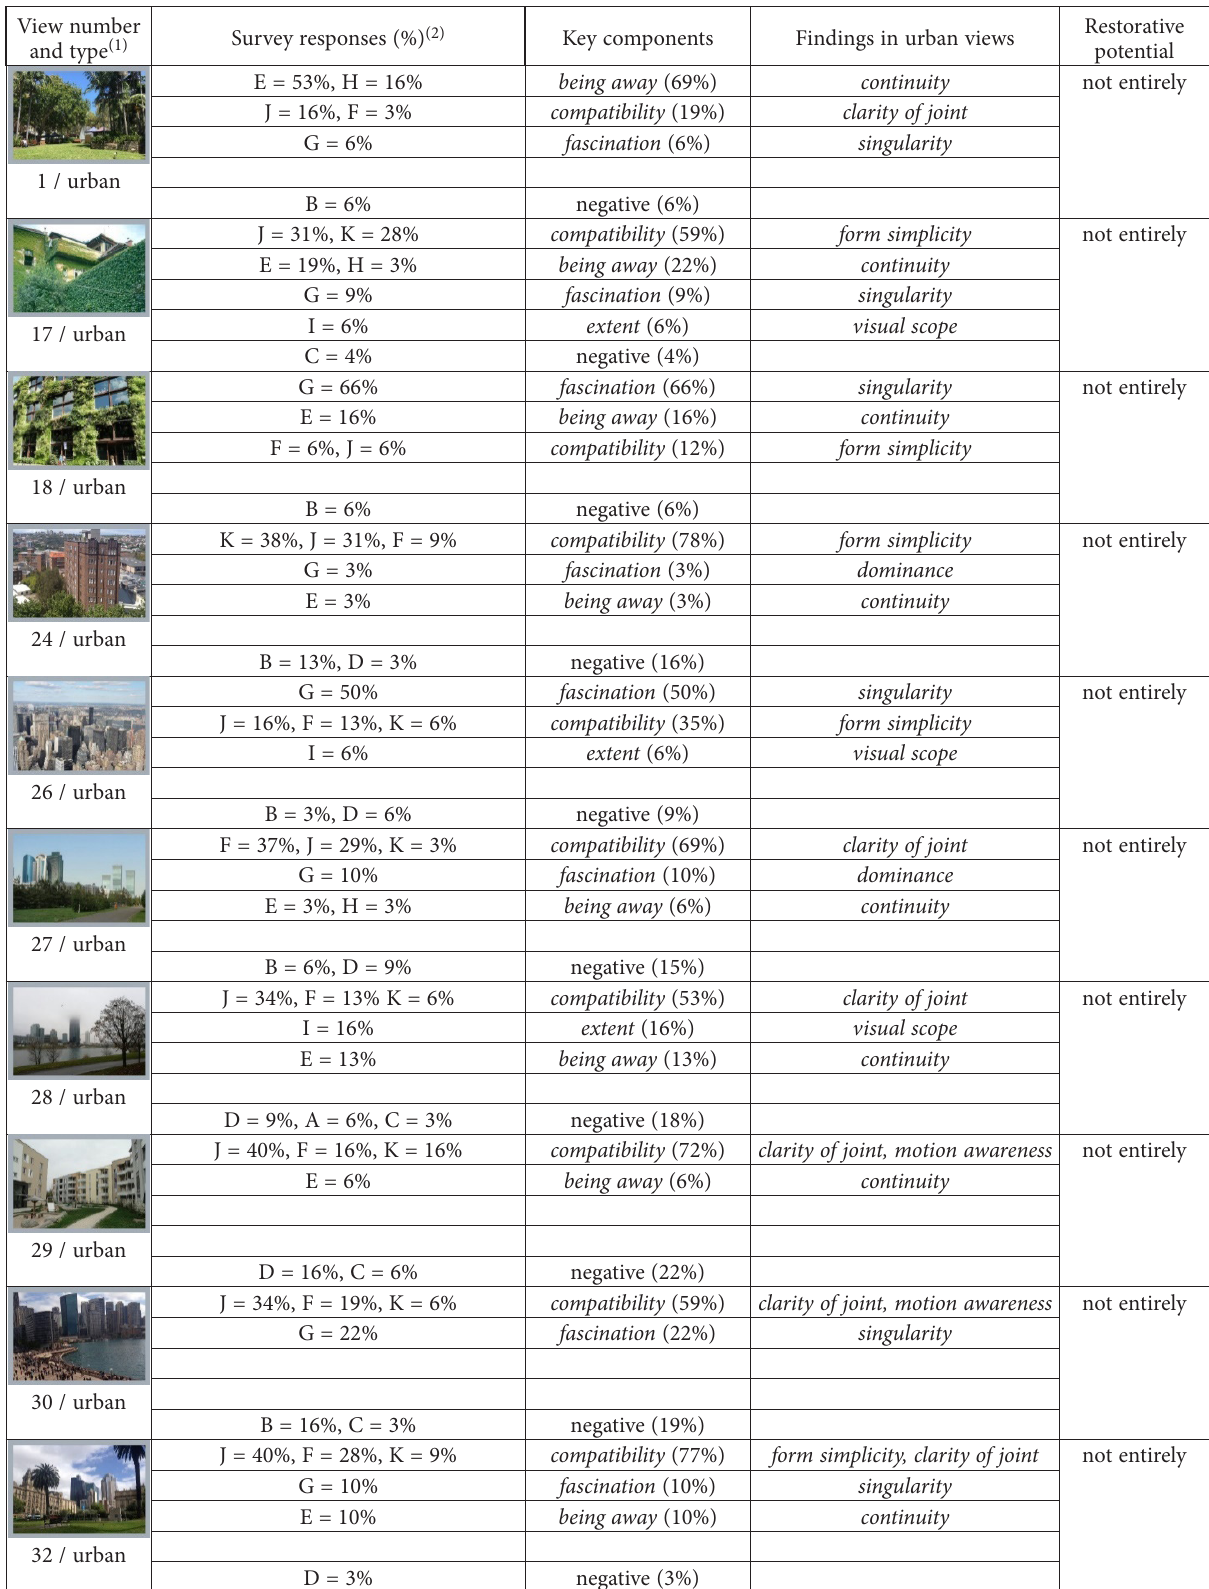
Table 3. Urban window views with minor negative